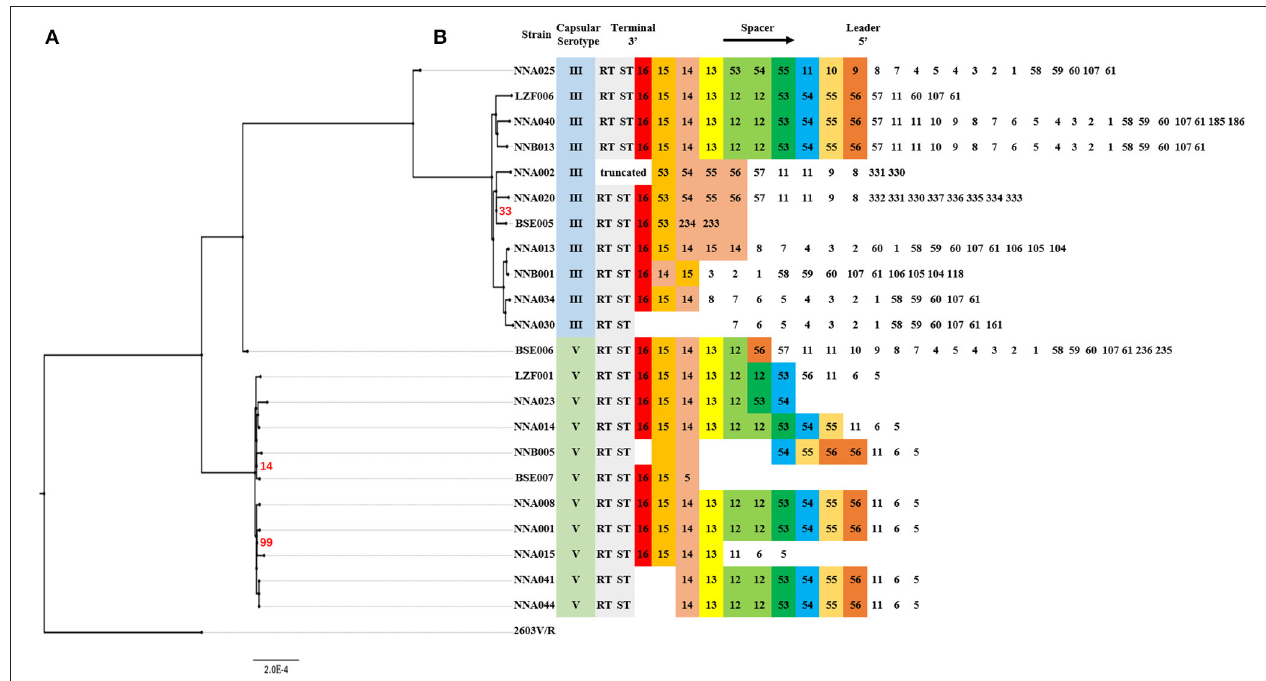
FIGURE 2 | Comparative analysis of systematic evolution and CRISPRs structure of ST19 GBS strains. (A) A Maximum Likelihood phylogenetic tree based on 1,707 single copy orthology clusters of the 23 strains, and 2603V/R strain was used as outgroup strain. The bootstrap confidence value which was 100 was not shown in the figure. (B) CRISPRs structure comparison. Direct repeat sequence was not included; only RT, ST, and spacers were represented. The spacers were numbered, and the same number highlighted with same color indicated that the spacer sequence was the